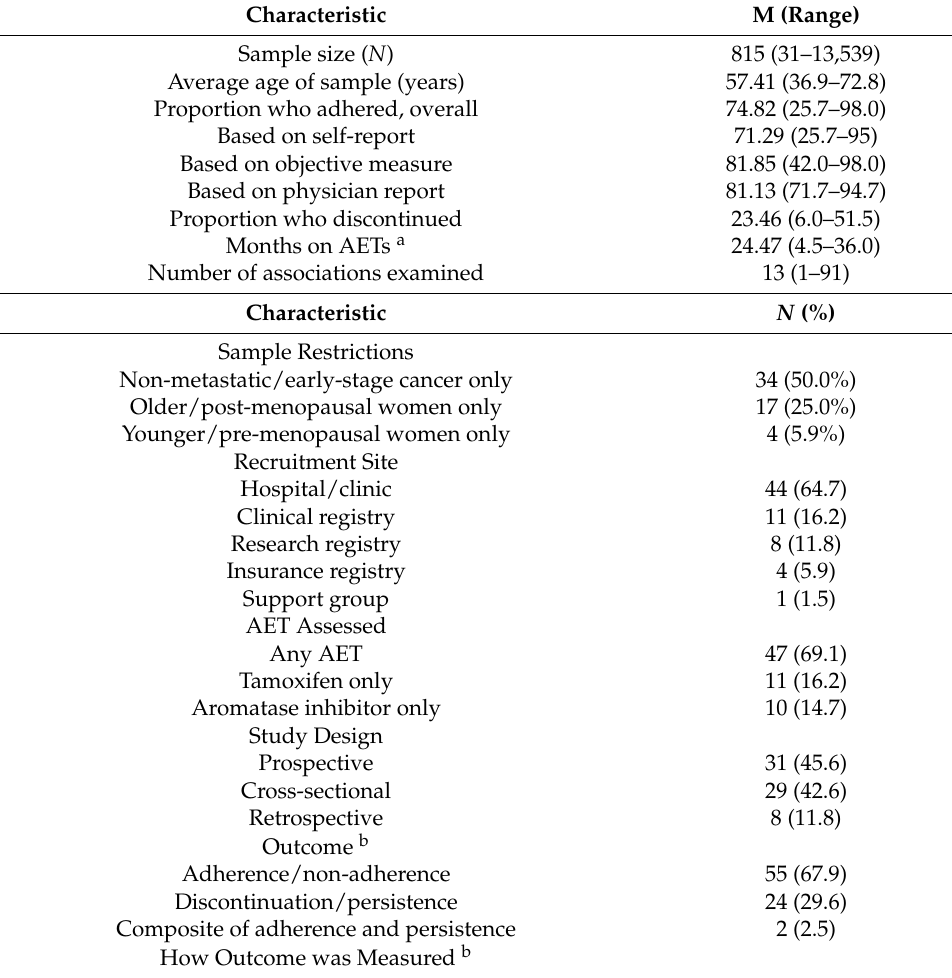
Table 1. Summary characteristics of all studies ( N =